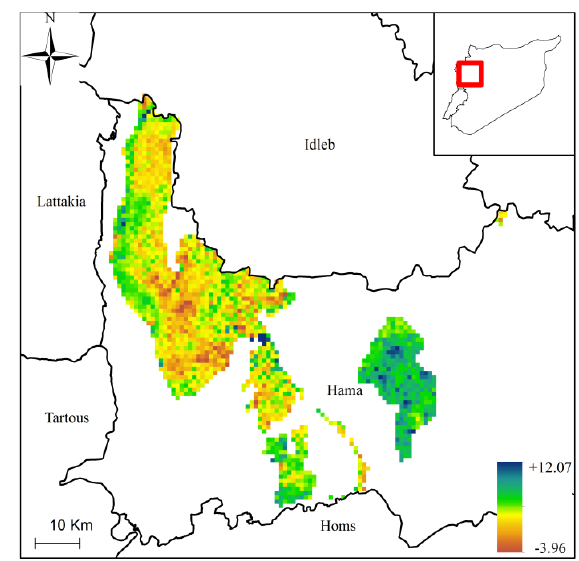
Figure 3- Standardized cumulative summer EVI for 2012 Hama.